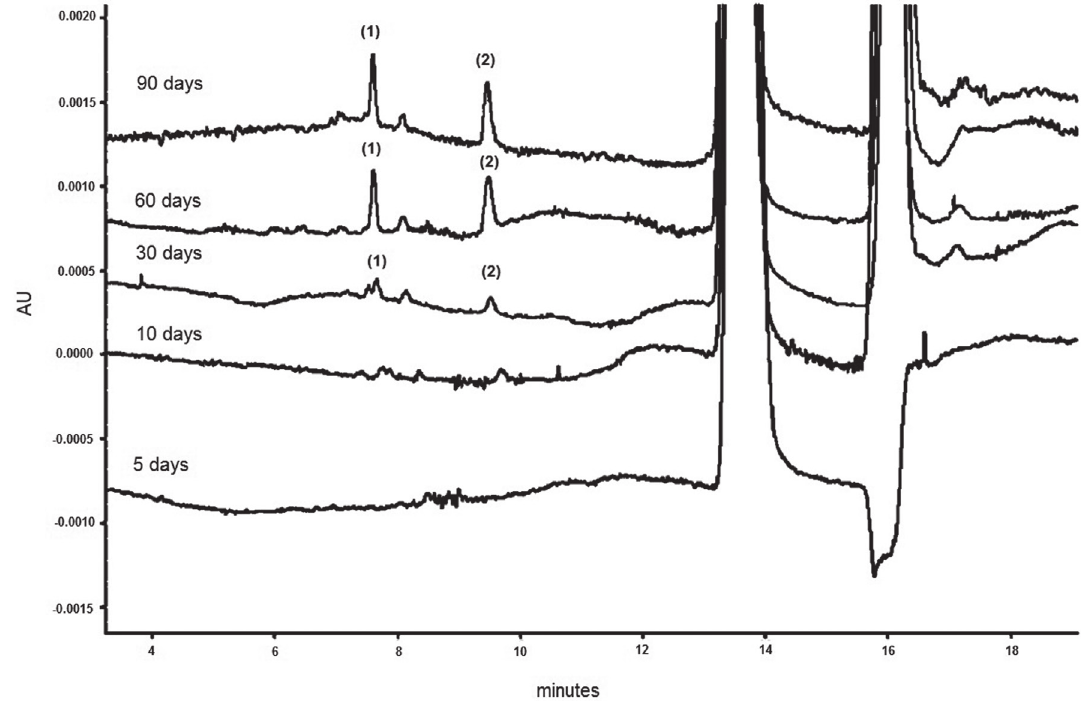
FIGURE 4 - Electropherogram of degradation products of LNZ tablet submitted to climate chamber (40 o C/75